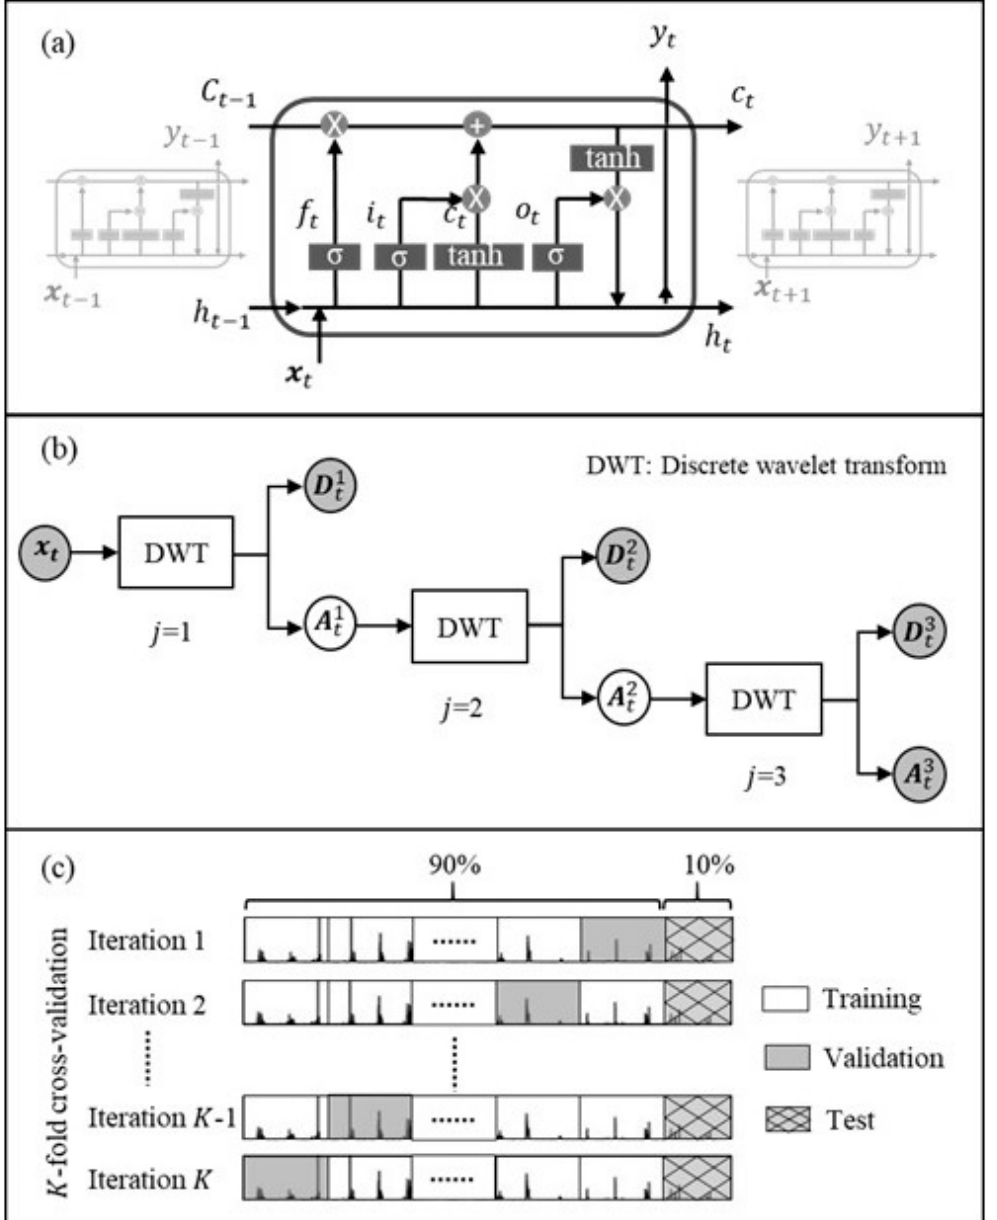
Figure 1. ( a ) The internal structure of long short-term memory (LSTM), where x t and y t denote input predictors and a target output; f , i , o stand for the forget, input, and output gate, respectively; c t , (cid:101) c t , and h t denote cell state, cell update, and hidden state at time t , respectively. ( b ) Diagram of wavelet transform; the input time series x t can be subdivided into multiple subseries down to the j -th level (i.e., D j and A j ); D j and A j denote ‘Detail’ and ‘Approximation’ time series of the original x t at the level j ; the input predictors and their subseries (shown as gray circles) are all used as the input of the LSTM models. ( c ) Schematic overview of K -fold cross-validation. The training and validation dataset (corresponding to 90% of total dataset in this study) is randomly split into K folds. A fold (shown as gray color) is used to validate the LSTM trained for the other folds (white color) at each iteration.